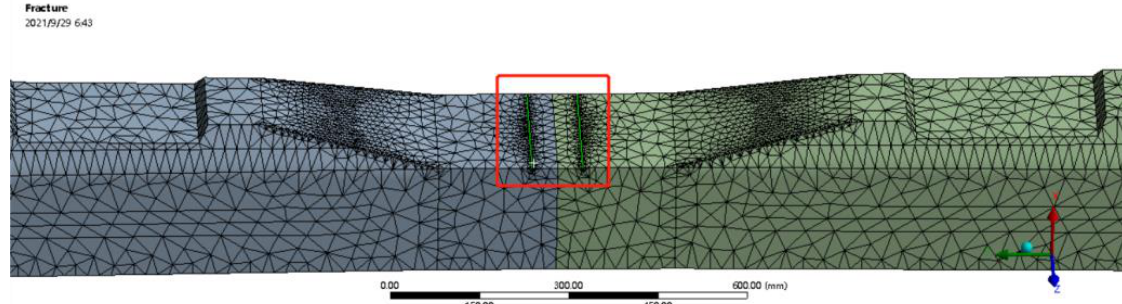
Figure 4. Crack propagation in the notches at midspan.